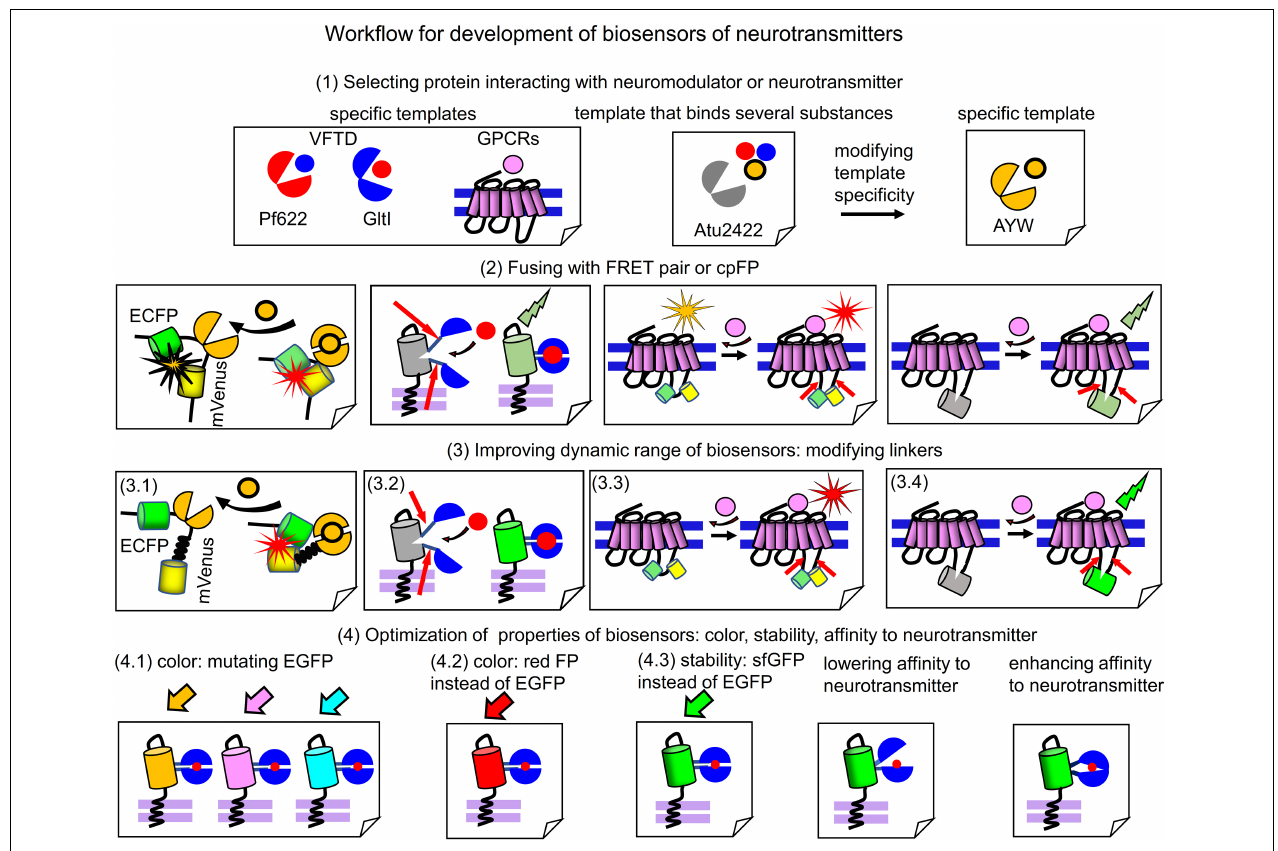
FIGURE 3 | Workflow for engineering of biosensors. (1) Selection of a protein template, which interacts with the respective neurotransmitter or neuromodulator. From left to right: specific templates that bind relevant chemical substance with high specificity, such as GPCRs, GltI from Escherichia coli or Pf622 from Pseudomonas fluorescens . A promising template, such as Atu2422 from Agrobacterium tumefaciens that binds glycine, GABA and L-serine is also shown. Atu2422 mutant AYW binds only glycine and is used in glycine biosensor (Zhang et al., 2018). (2) Fusing of neurotransmitter-binding protein templates with FRET pairs of FPs or cpFPs. From left to right: Glycine-binding AYW is inserted between ECFP and mVenus; cpEGFP is inserted in the flexible region of GltI (Hires et al., 2008). FRET pair or cpFP is inserted in the third intracellular loop of GPCRs. Note the low dynamic range of relevant fusions. (3) Improving dynamic range of the initial fusions. (3.1) Deleting the flexible regions between ECFP and AYW in GlySF biosensor and inserting the rigid helical linker between AYW and mVenus (3.2) Mutagenesis of linkers joining VFTD domain and cpEGFP in a biosensor. (3.3 and 3.4) Mutagenesis of regions of the third intracellular loop of GPCRs in the point of insertion of FRET pair or cpFP. (4) Optimization of properties of resulting biosensors with high dynamic range. Manipulating color, stability and response dynamics. (4.1) Mutations, which change color of EGFP to yellow (mVenus), cyan (mTurquoise) and blue (mAzurite) are introduced in the cpEGFP-based biosensor to get a set of multicolor biosensors (Marvin et al., 2018). (4.2) EGFP is changed to mApple to get novel red fluorescent biosensor (Wu et al., 2018). (4.3) EGFP is changed to sfGFP to enhance biosensor stability. (4.3) Lowering affinity of the neurotransmitter-binding protein to the neurotransmitter allows to get biosensors able to detect fast neurotransmitter transients (Helassa et